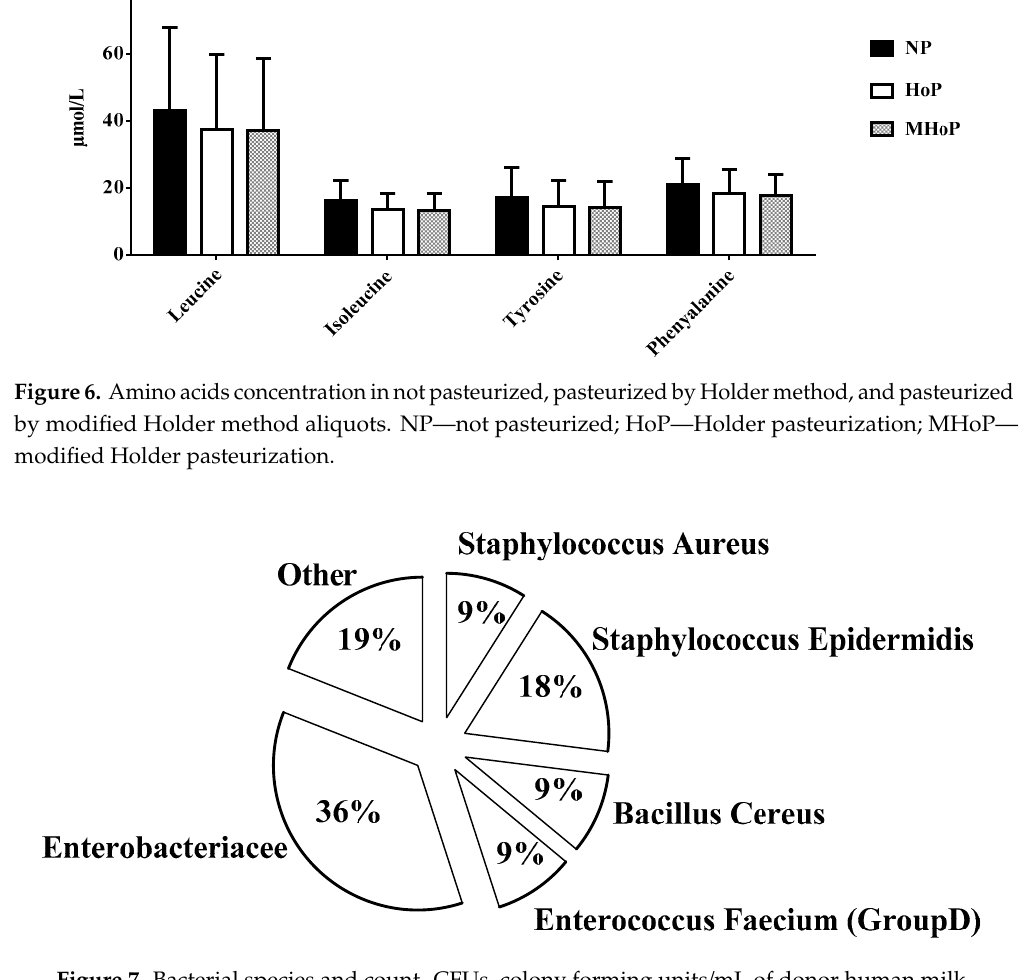
Figure 7. Bacterial species and count. CFUs–colony forming units / mL of donor human milk.